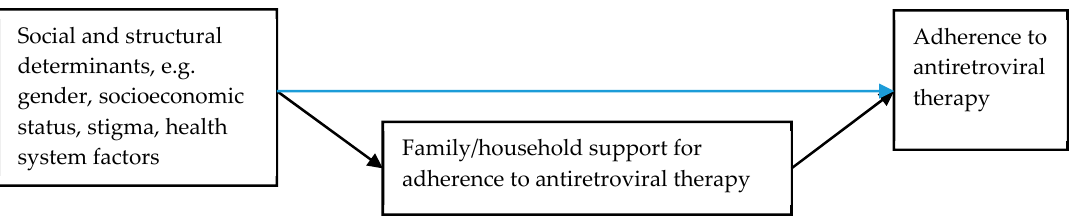
Figure 2. Social and structural determinants may directly affect the adherence behaviour of people living with HIV, or indirectly via the type and quality of support given by household members. This review concentrates on the indirect relationship.